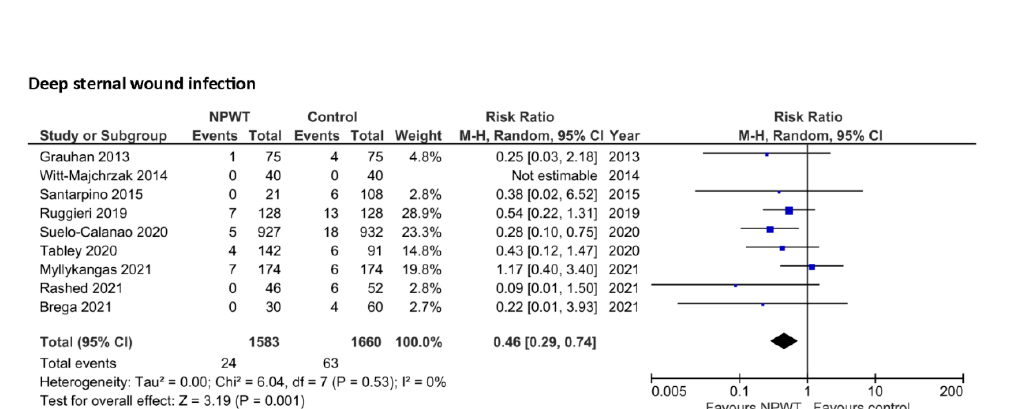
Figure 1. Forest plots of study interventions and outcomes [11–20].